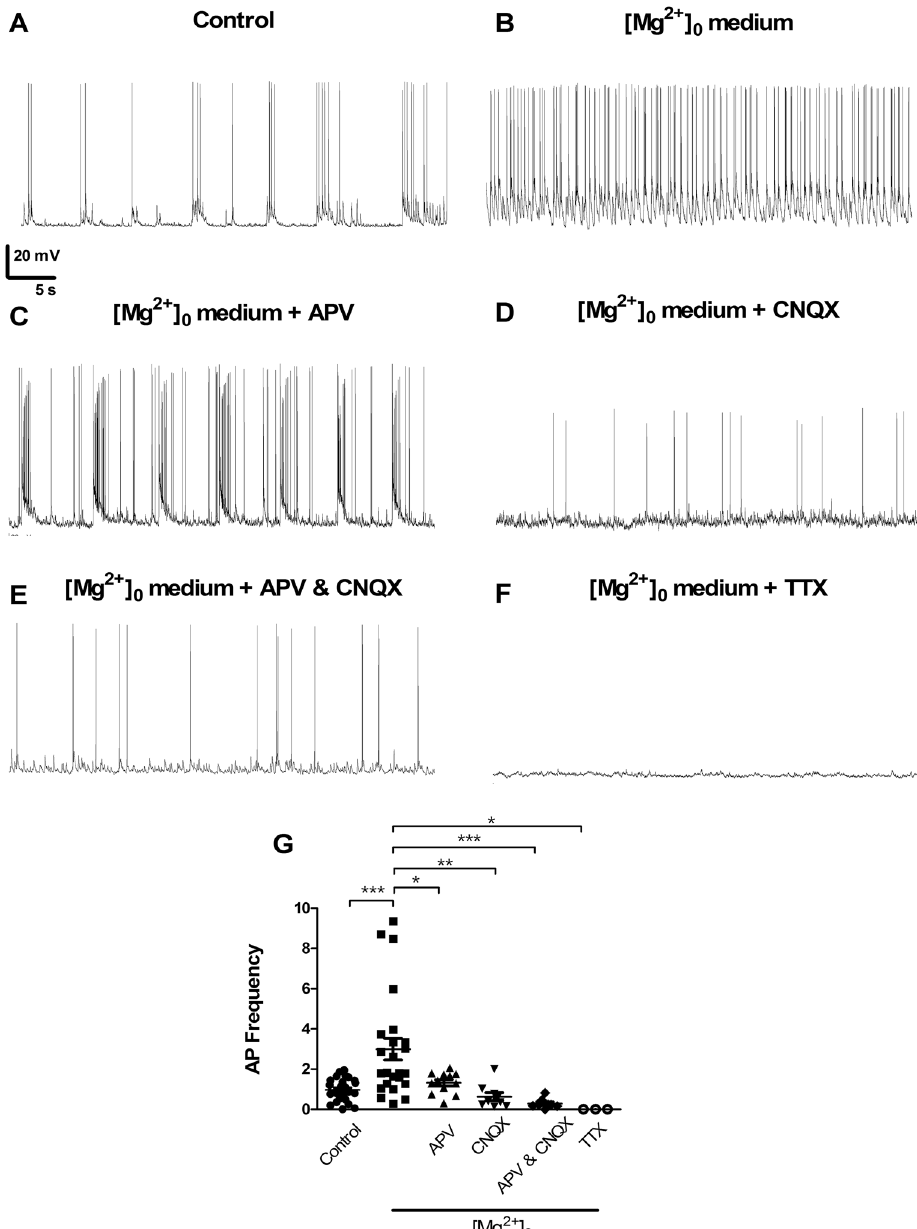
Figure 1. The increased neuronal firing upon treatment in [Mg 2+ ] 0 medium is glutamate receptor-dependent. The cells were incubated for 15 min in Mg 2+ -free solution in the absence of drugs, and recordings were performed in the same buffer for 25 min under the conditions indicated below. Representative recordings in control conditions (n = 24) and in [Mg 2+ ] 0 medium (n = 20) are shown in panels ( A , B ), respectively. Representative recordings performed in [Mg 2+ ] 0 medium and in the presence of APV (50 µM; NMDAR inhibitor) (n = 10), CNQX (20 µM; AMPAR inhibitor) (n = 9) and CNQX (20 µM) and APV (50 µM) (n = 8) are shown in panels ( C – E ), respectively. ( F ) Representative recording in SE condition in the presence of TTX (500 nM) (n = 3). ( G ) Summary data of action potential firing frequency under the different experimental conditions. The results were normalized for the mean frequency of action potential detected under control conditions. The results represent the fold change (mean ± SEM) of at least 3 independent experiments performed in distinct preparations. * p < 0.05, ** p < 0.01, *** p < 0.001; one-way ANOVA followed by Bonferroni